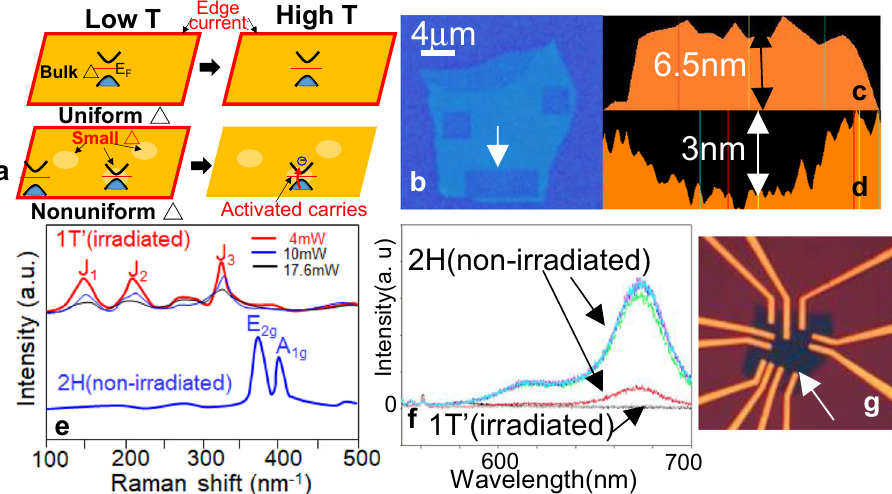
Fig. 1 Device fabrication and characterization. a Schematic views of bulk gaps Δ and edge current for uniform and nonuniform cases at low and high temperatures. Thermally activated charge carriers can overcome small Δ located at some parts of the nonuniform sample as temperature increases, obliterating the presence of helical edge states. This can be one of causes why high-temperature quantum spin Hall (QSH) phase has not been observed. b Optical and c , d cross-sectional atomic force microscope images of a MoS 2 fl ake. The semitransparent rectangle parts in b are the low- power laser-beam irradiated regions. The region shown by an arrow is used for the present experiment. c Pro fi le before laser irradiation. d Pro fi le for the laser-irradiated part showing reduction of the layers due to the burn out caused by excess heat accumulation by laser irradiation. It results in the semitransparent parts in b . e Raman and f Photoluminescence spectra at the partial points for the laser irradiated and non-irradiated regions. The spectra for the irradiated parts in e are the results for three different laser powers and J 1 -J 3 peaks unique to the 1T ′ phase grow as laser power decreases, suggesting all the 2H phase layers have been changed into the 1T ′ phase with a high-crystal quality. In f , no signals are obtained in this wave range from the irradiated part, indicating that all the 2H- phase layers have been converted into either a metallic phase or the 1T ′ topological phase with much smaller bulk gaps. g Optical microscope image using b with Au/Ti electrodes. The region shown by an arrow corresponds to same region in b , mainly used for the present